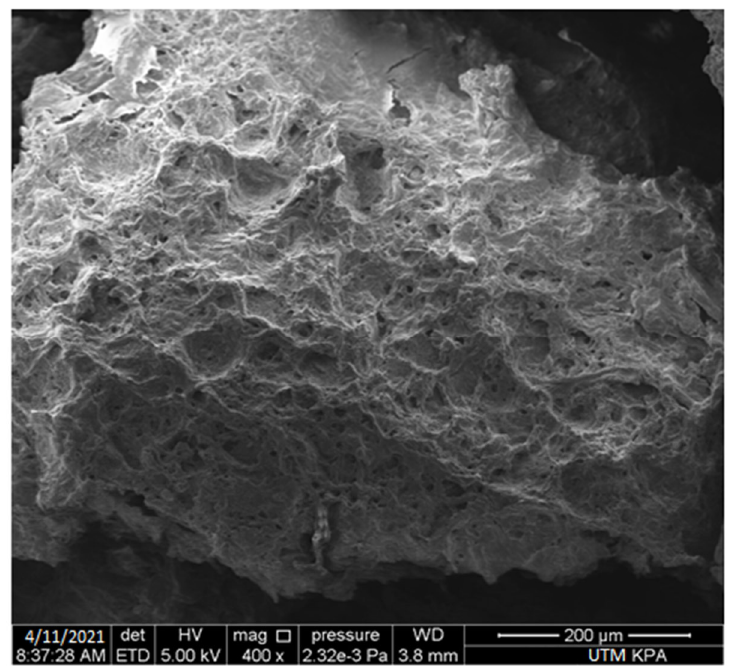
Figure 3. Percent swelling of formulations (F1–F7). Data are expressed as the mean ± SD; n = 3, one ‐ way ANOVA followed by the post hoc Tukey test ( p < 0.05), F1 vs. F7 ( p < 0.05).